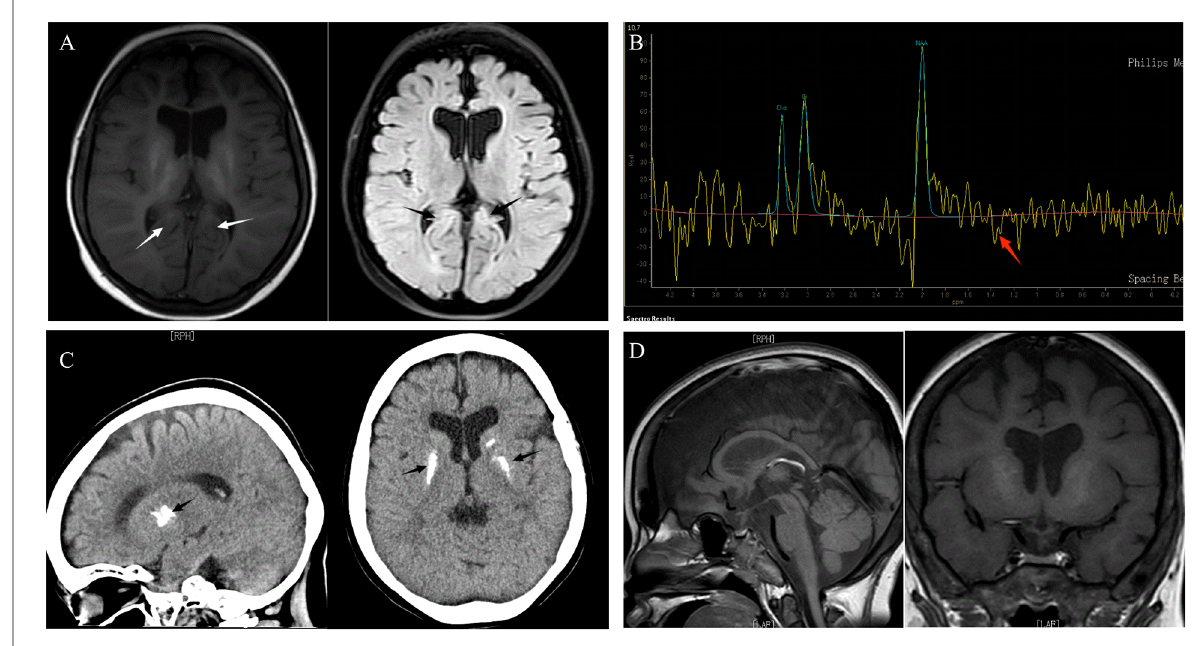
FIGURE 2 The patient ’ s MRI and brain CT scan fi ndings of brain and pituitary abnormalities. ( A ) Brain MRI: axial T1, axial T2 FLAIR: On T2-FLAIR, a strip of marginally elevated signal may be observed near to the posterior horn of both ventricles (arrows), indicating enlargement of the two ventricles and shrinkage of the brain ’ s white matter. ( B ) MRS: mildly increased lactate peak. ( C ) CT scan: basal ganglia calci fi cations. ( D ) Pituitary MRI: the pituitary gland was slightly tiny, measuring 2.60 mm in height, without constriction, with uniform pituitary signal, evident strong signal in the posterior pituitary lobe, and visible pituitary